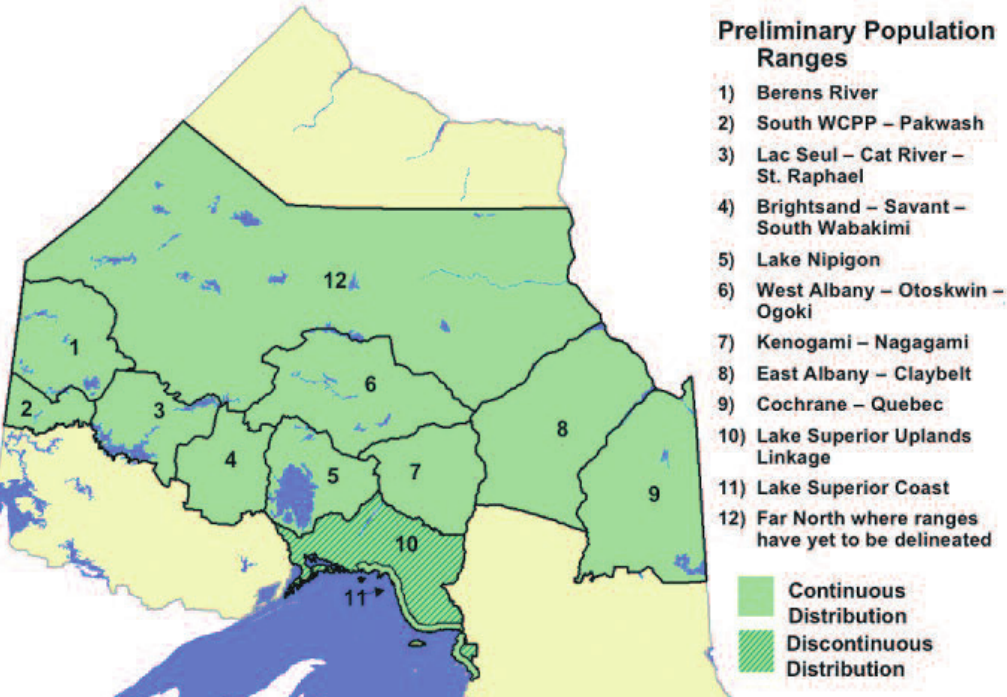
Fig. 1. Preliminary population ranges of the forest-dwelling population of woodland caribou outlined in the Ministry of Natural Resources’ NR’s (2009) Ontario’s Caribou Conservation Plan. The conservation plan applies to the continuous (shaded area) and discontinuous (thatched area) range of the forest-dwelling population of woodland caribou. It does not include the range of the forest-tundra population of wood- land caribou in the northernmost part of